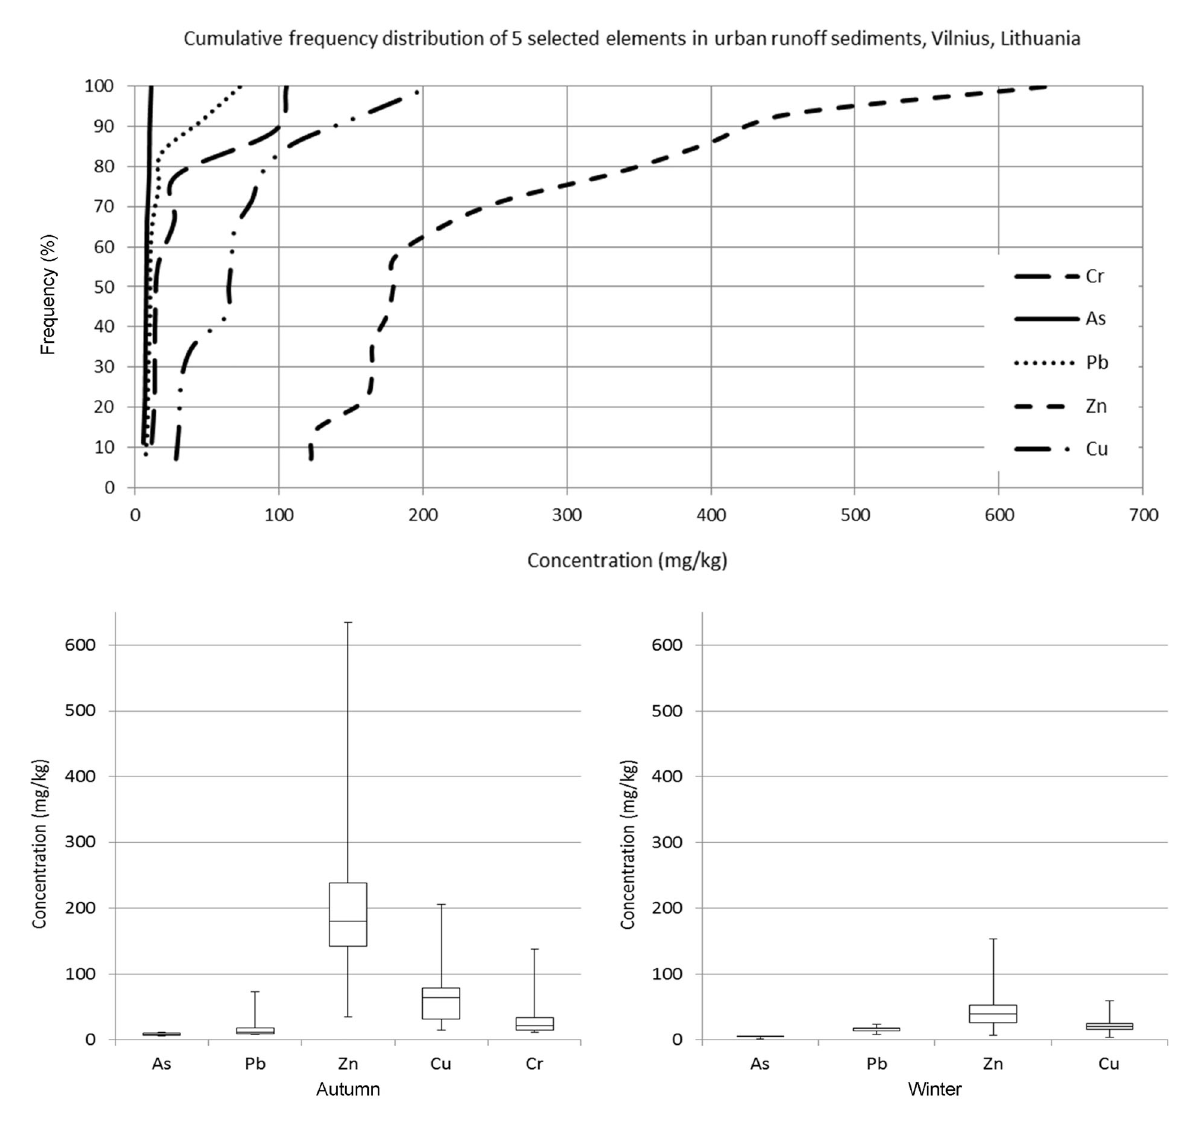
Fig. 2. Cumulative frequency distribution of Cr, As, Pb, Zn and Cu in urban runoff sediments of Vilnius ( N = 21) and maximum, minimum and median values of their concentrations during autumn and winter